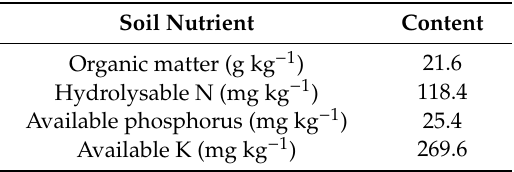
Table 2. The nutrient conditions of the top 20 cm soil layer in 2016.